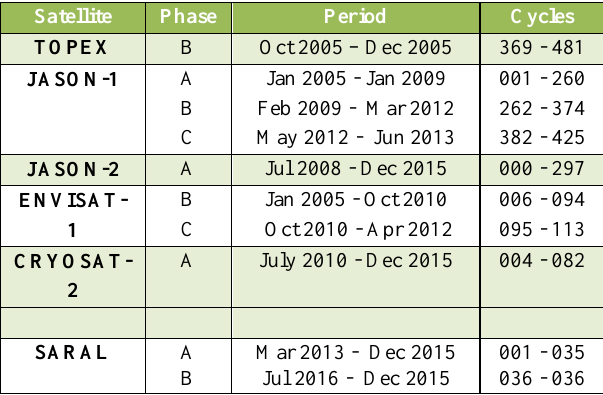
Table 2. Satellite Altimetry Data Processed in RADS